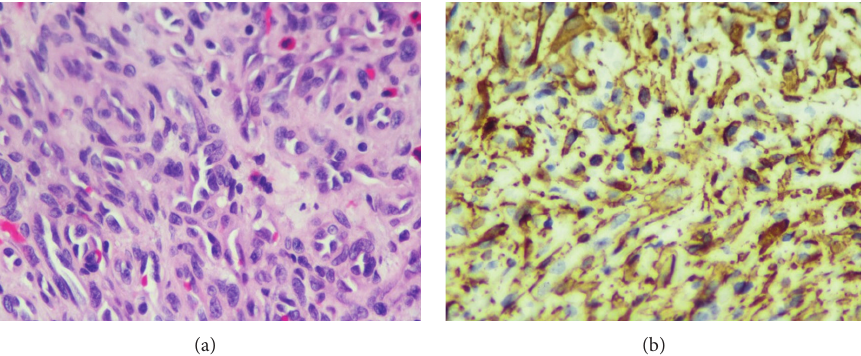
Figure 3: (a) Thin-walled vessels with a concentric, perivascular gathering of spindled myoid tumor cells (HE-Stain, × 40). (b) Pericytes stained positive for